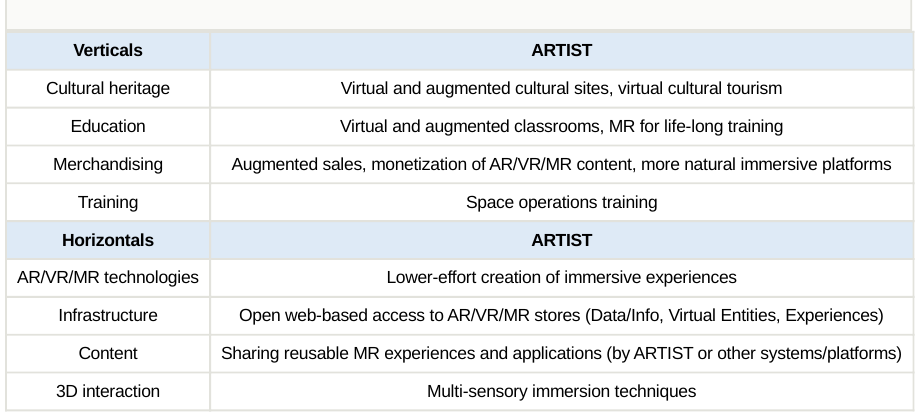
Impact in EU vertical and horizontal dimensions of AR/VR/MR technology